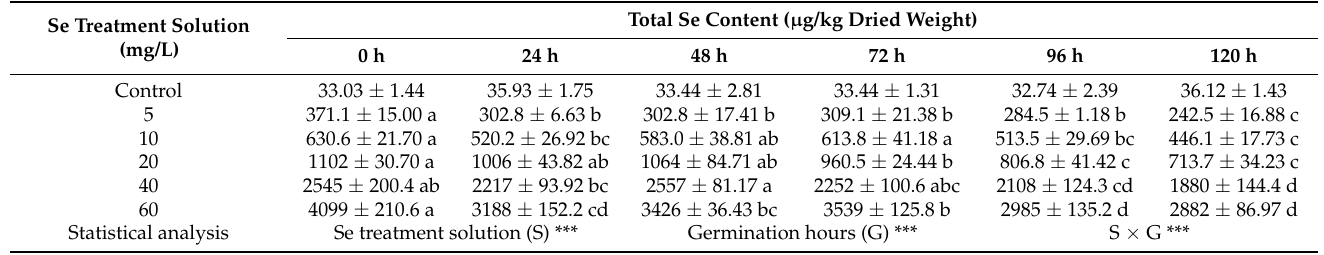
Table 1. Total Se concentration during soybean germination with different concentration Se treatment. Se Treatment Solution